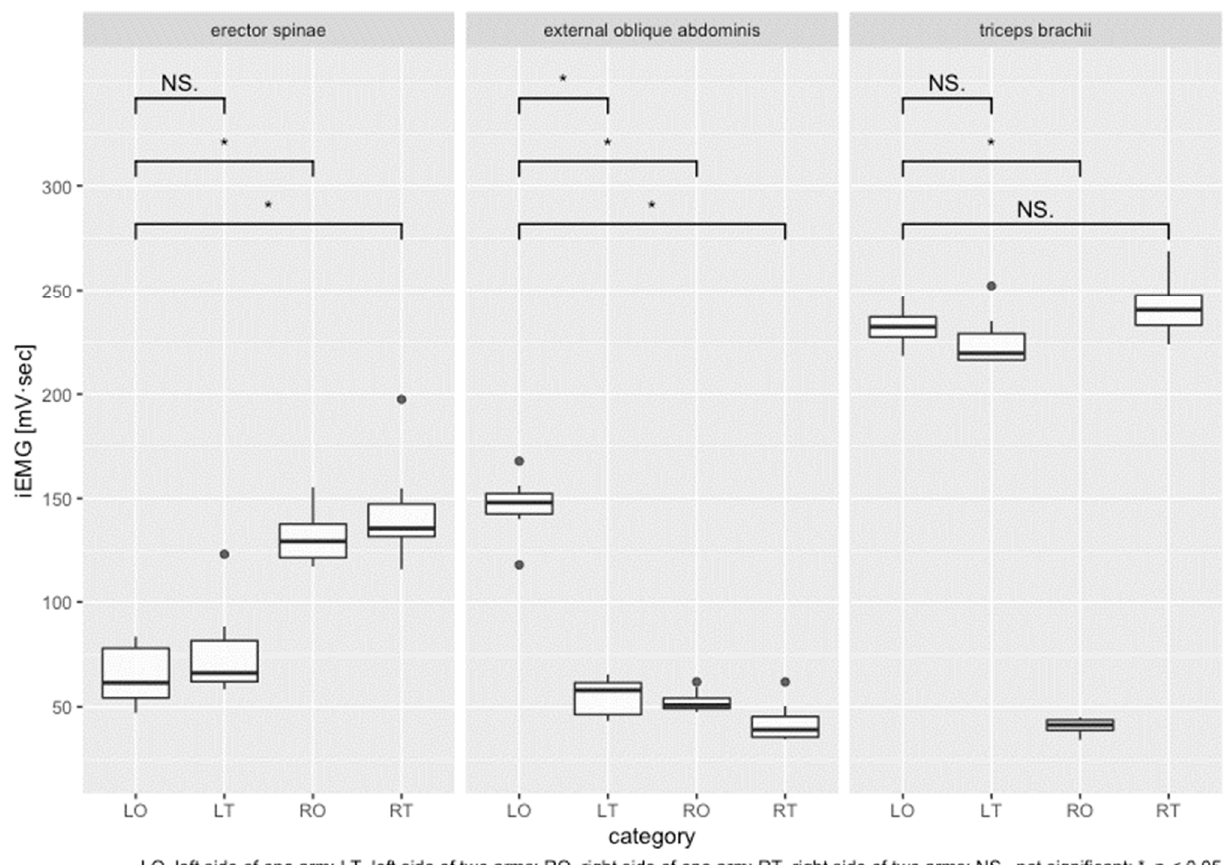
Figure 8. Distribution of iEMG results obtained at each muscle site with one-arm and two-arm driving (by left and right side).